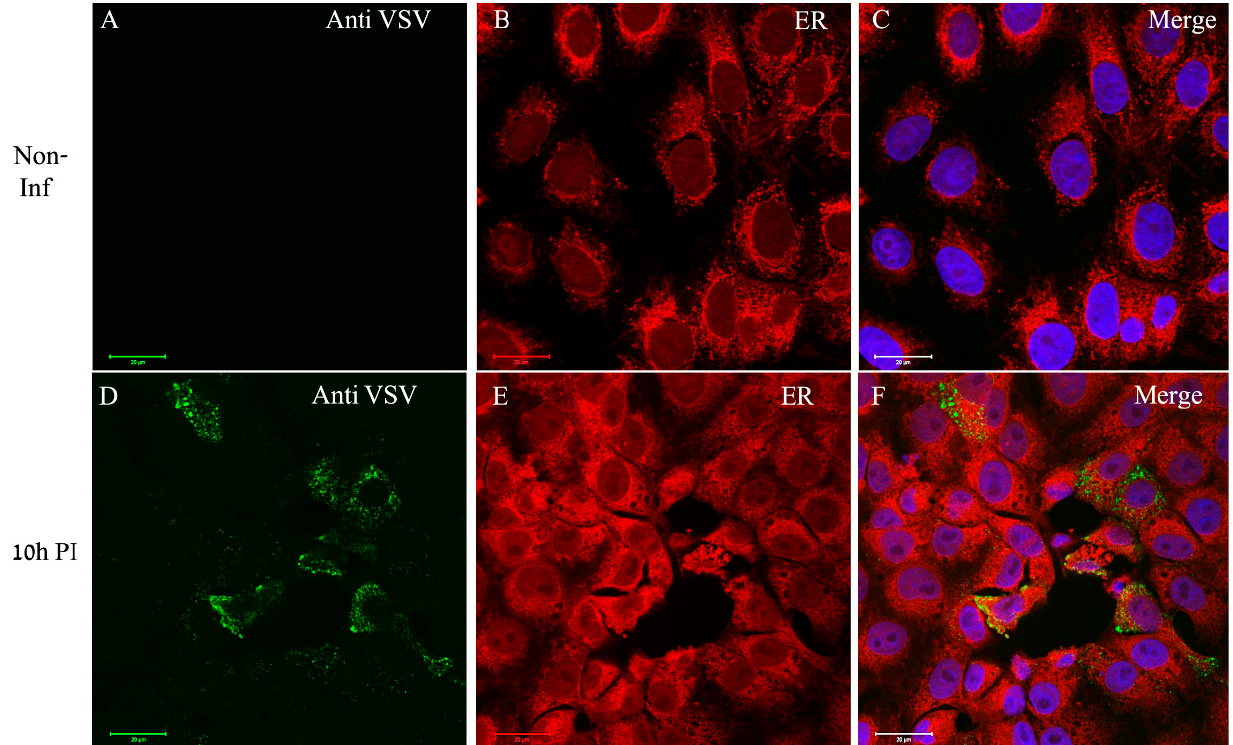
Figure 6. VSV-S proteins accumulate at distinct sites in the cytoplasm where ER is absent. ( A – F ) Cells were either mock or VSV-S infected for 10 h and then processed for immuno-labeling with anti-VSV antibodies ( A , D ) or stained for ER detection ( B , E ). ( A – C ) In non-infected cells the ER (red) accumulates around the nuclei. ( D – F ) At 10 h PI, VSV-S proteins (green) accumulate in regions where ER is absent. ( C , F ) Merge channels of both ER, VSV proteins and DAPI (blue) for nuclei staining. Scale bars are 20 µm. Objective lens X63.